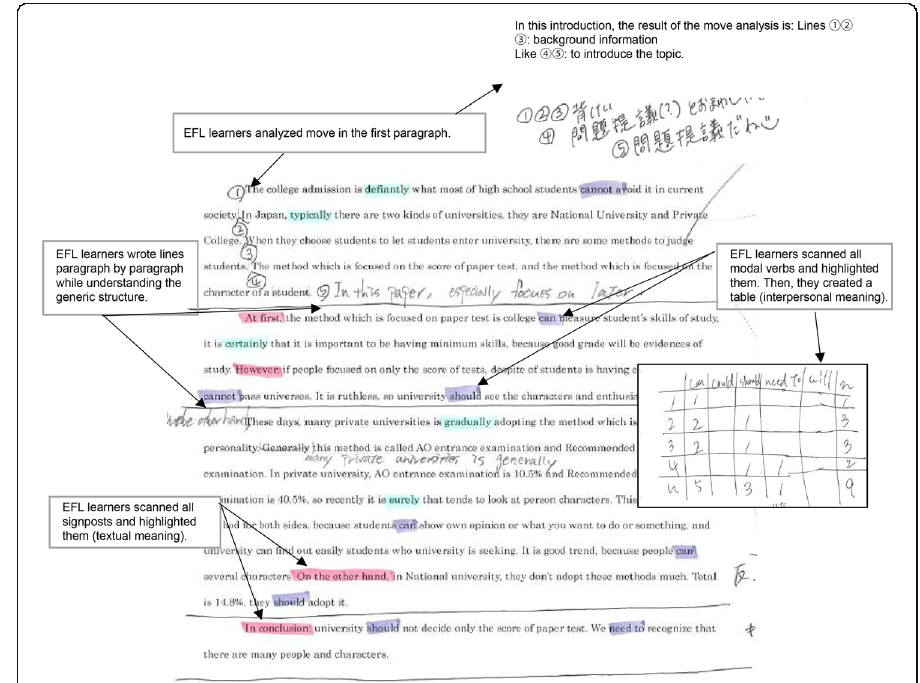
Fig. 1 An example of a learner ’ s discussion genre text with genre analysis from the lower English proficiency group during stage (3) of the